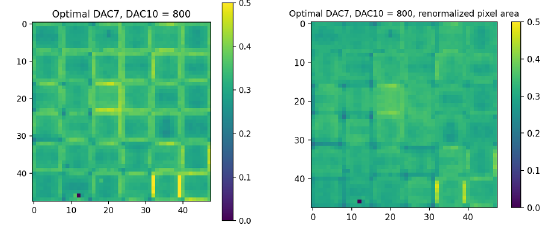
Figure 8. Full PDM illumination. Color means detection e ffi - ciency. Left: e ffi ciency assuming the average pixel size equal for all pixels. Right: renormalized e ffi ciency, taking into account the individual pixel areas.